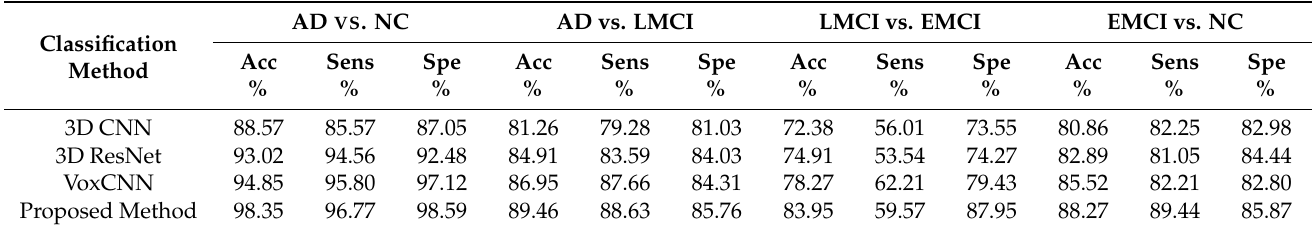
Table 3. Comparison of results of several classification Table 3 . Comparison of results of several classification algorithms.